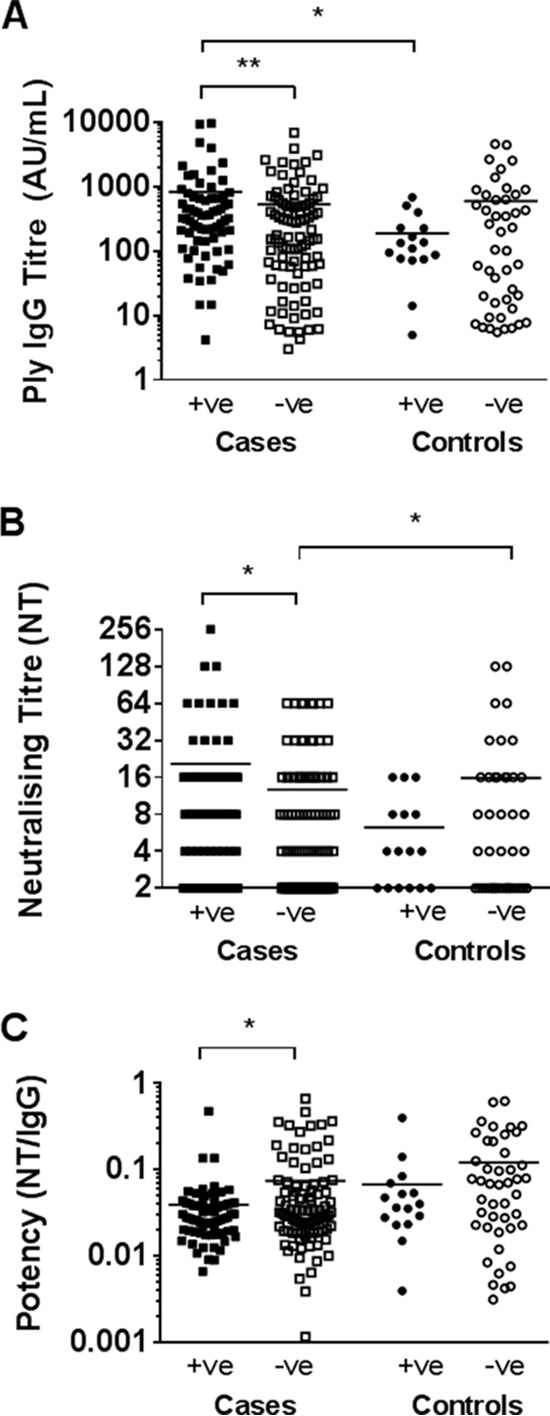
Pneumolysin antibody IgG titers (A), neutralizing titers (B), and antibody potency (C) in sera from otitis-prone (cases) and healthy (controls) children according to nasopharyngeal colonization with S. pneumoniae. Data are presented for each individual child, with the horizontal bars depicting the means. Statistical analysis was conducted on the geometric mean of log-transformed data, correcting for age, gender, and day care attendance. Closed data points represent children colonized with S. pneumoniae, and open data points represent noncolonized children. **, P < 0.001; *, P < 0.05.